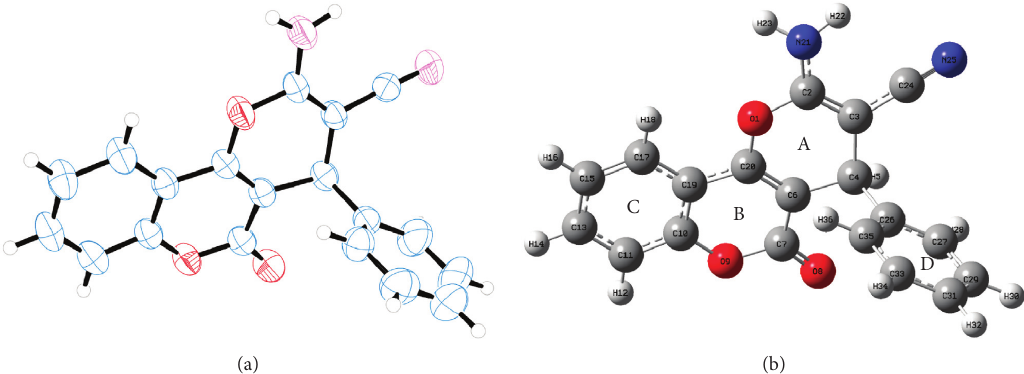
Figure 2: The molecular structure of Chrom-D (a) shown at 50% ellipsoid probability and (b) optimized at the B3LYP/6-311++G(d,p) level of theory along with numbering of atoms (A and B denote the pyran rings; C and D denote the phenyl Figure S1. Herein, the complete Hirshfeld surface indicates that the overall intermolecular interaction is maintained by H . . . H (37%), H-C (18.6%), H-O (18.5%), and H-N (13.6%)